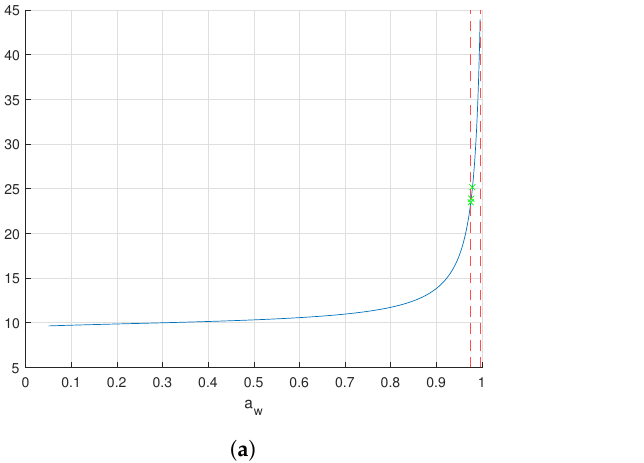
Figure 4. SC thickness and water activity relationship. ( a ) The blue line indicates the SC thickness in relation to the water activity according to Equations (7)–(9). The red dashed line on the left marks the water activity at ambient relative humidity of 0% at a w = 0.9745. The red dashed line on the right marks the water activity at ambient relative humidity of 100% at a w = 0.996, which is equal to fully hydrated SC. The dry SC thickness is 9.55µm. The non-linearity is clearly visible. In the low water activity range a w < 0.95, the SC thickness only grows approximately 5µm. However, in the higher water activity range a w < 0.95, the SC thickness grows by approximately 30µm. ( b ) Zoom of the SC thickness δ in relation to the water activity a w into the marked range. The three green marks on the blue line indicate the resulted thickness of the SC exposed to ambient relative humidity of 40%, 60%, and 80% for 30min, see Supplementary